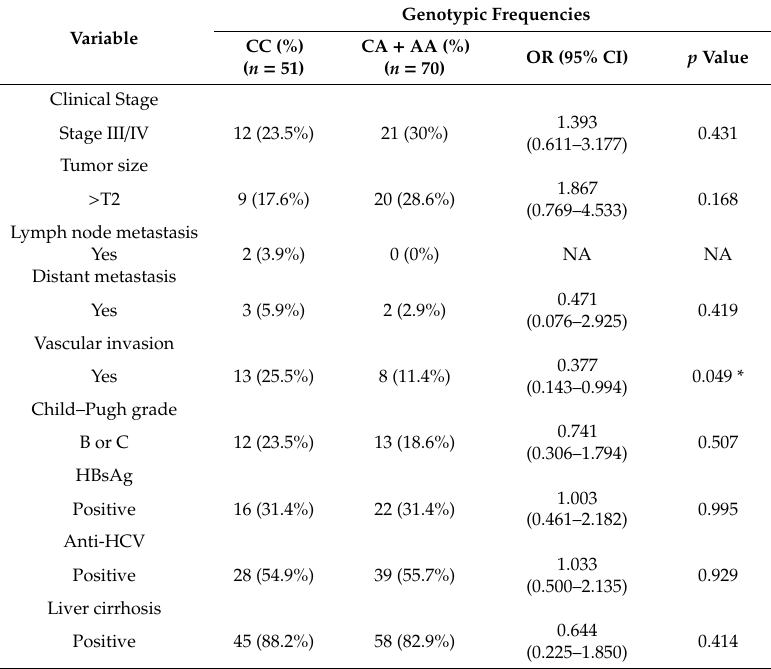
Table 4. Odds ratio (OR) and 95% confidence interval (CI) of clinical status and MALAT1 rs1194338 genotypic frequencies in 121 female hepatocellular carcinoma patients.